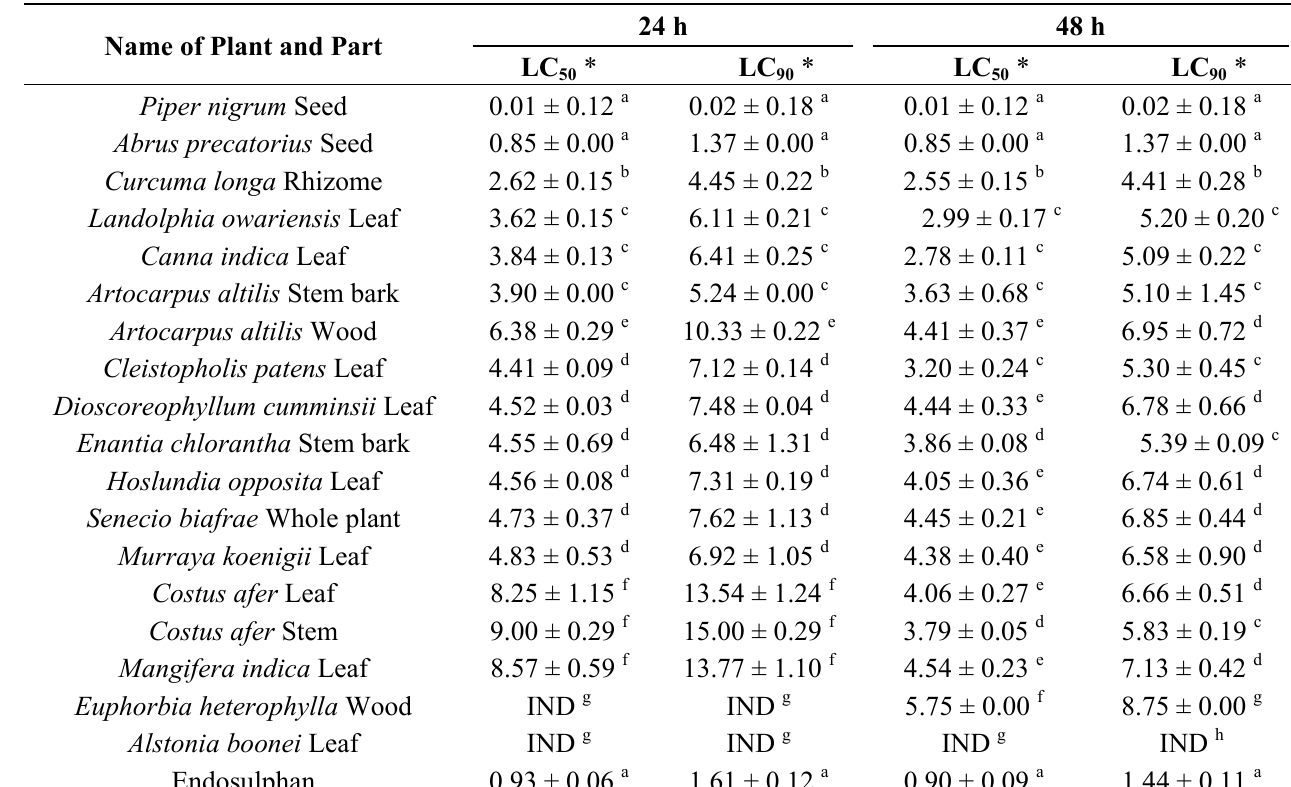
Table 2. Larvicidal activities of the methanolic extracts of some Nigerian medicinal plants against Aedes aegypti